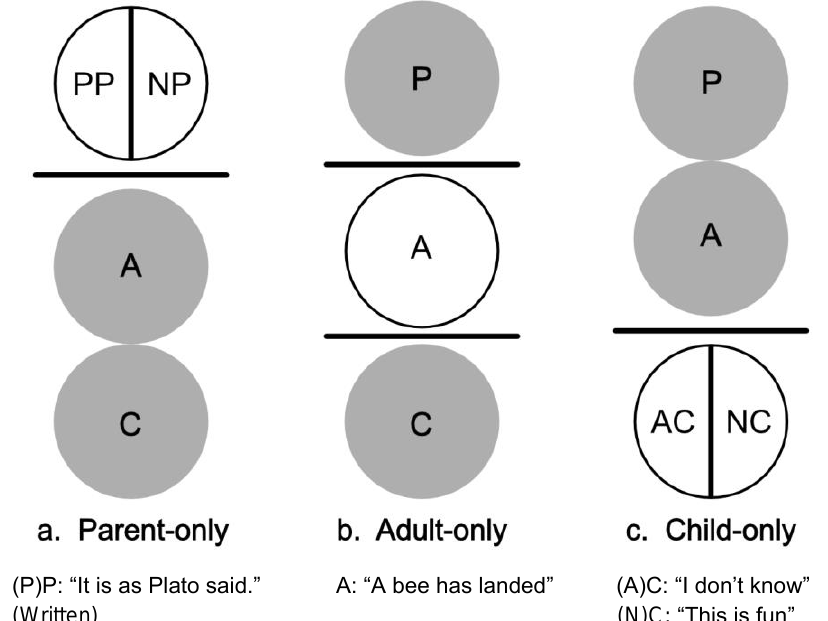
Figure 4: Scientist with Single Ego State